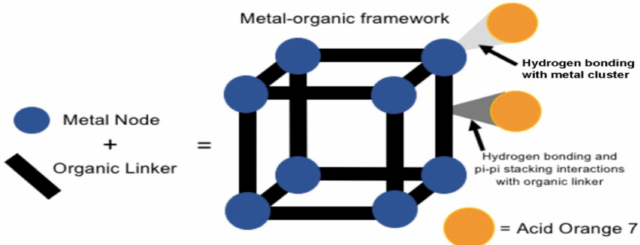
Figure 2. Interactions in adsorption of a contaminant (acid orange 7) onto the pores of MOFs. Reproduced with permission from Reference